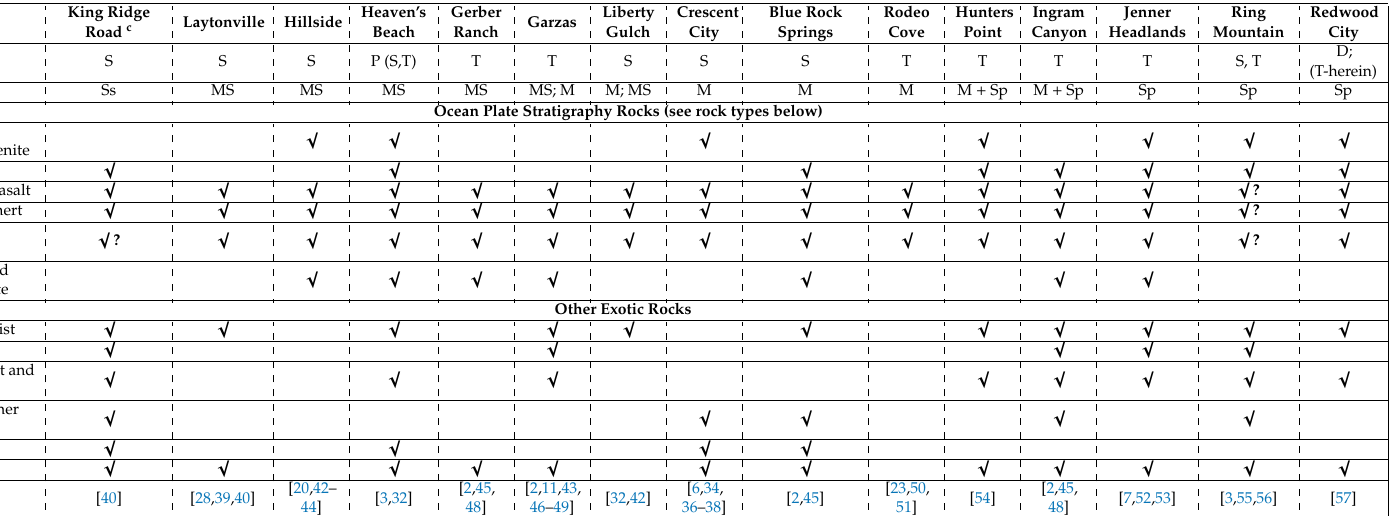
Table 2. Exotic block content of selected Franciscan m é